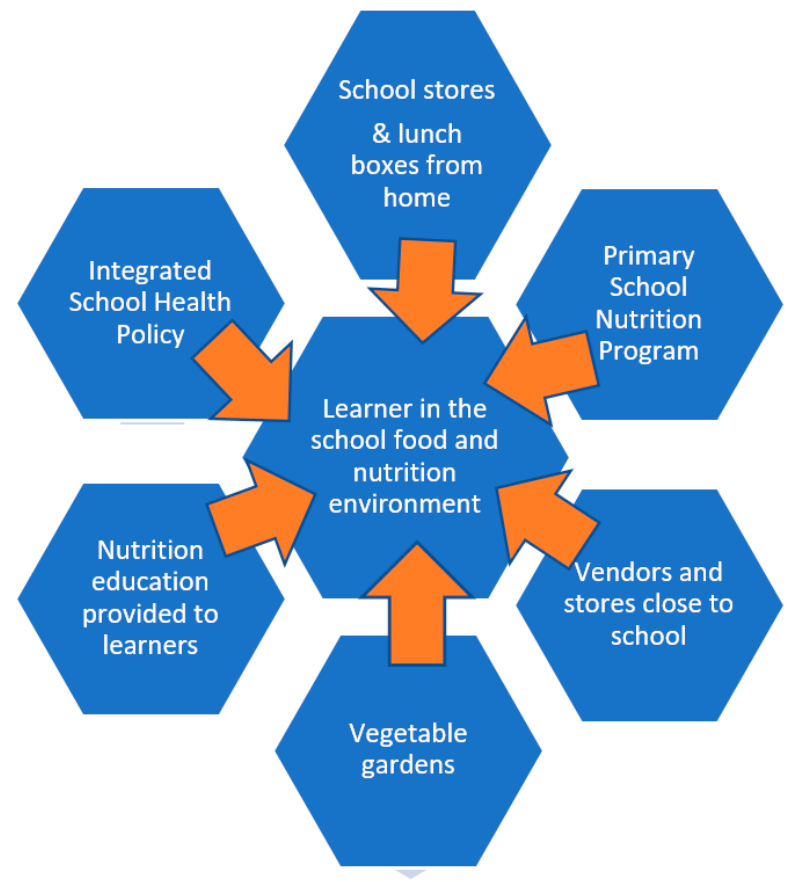
Figure 2. A schematic view of the factors influencing the school food and nutrition environment.